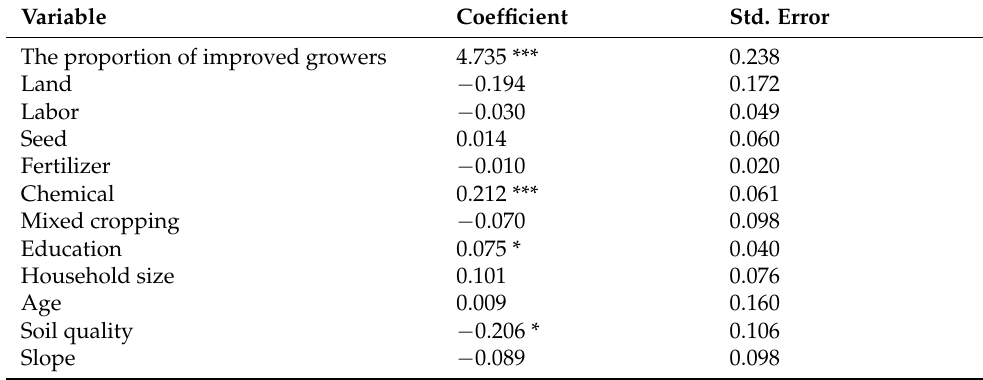
Table A1. First stage of linear endogenous treatment—effect